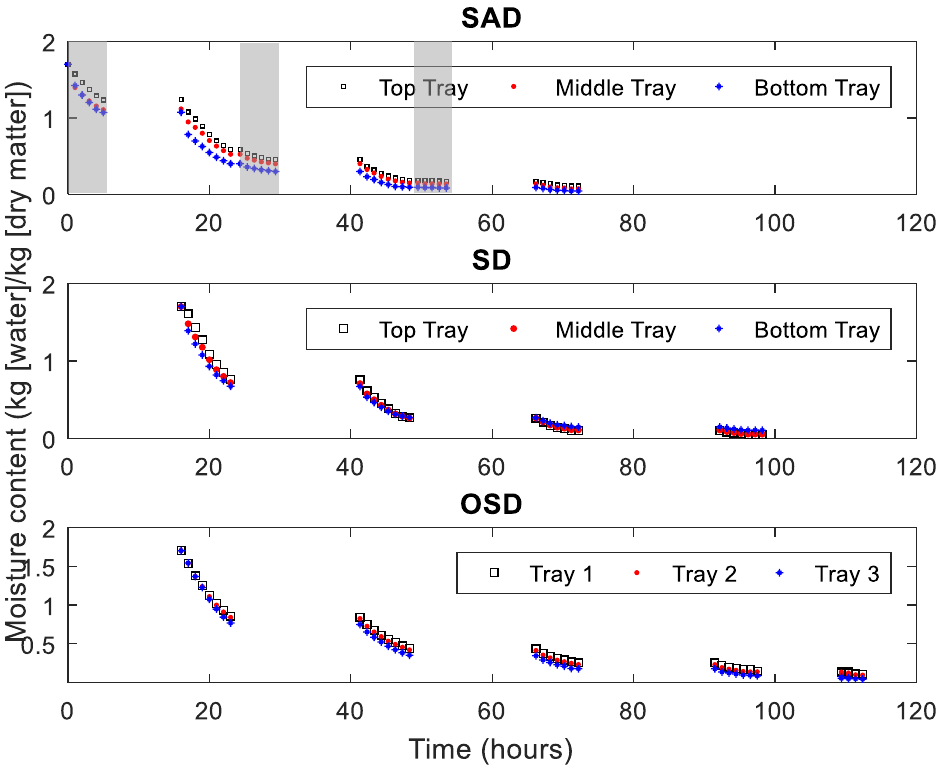
Figure 5. Moisture content of yam particles (‘Dente’) at different positions in the dryers as a function of time for SAD, SD and OSD. The grey portions represent night drying.